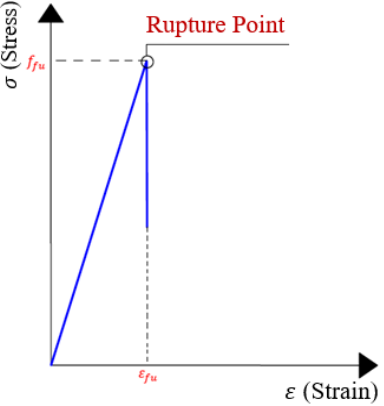
Figure 7. Fiber-Reinforced Polymer Stress–Strain Curve [39] .